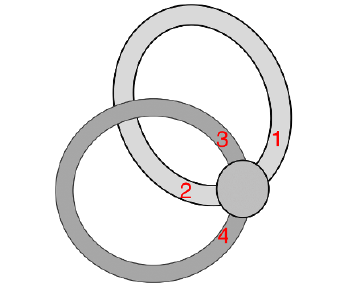
Figure 1 . A genus one ribbon